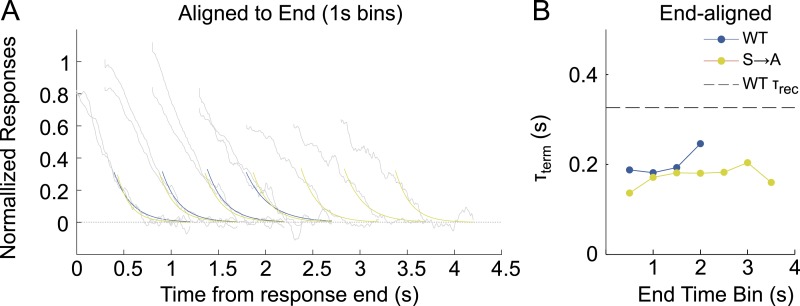
Termination-aligned S → A responses exhibit recovery time constants of ∼200 ms.(A) Responses from WT and S → A lines were binned according to their duration, in 1-s wide bins every 0.5 s (oversampling) and aligned to their termination points (gray lines). An exponential function (A*exp(−t/B)) was fit to the decline, after crossing a defined threshold (0.25) (blue, WT; yellow, S → A). (B) Time constant of termination-aligned decay (τterm) as a function of the bin center. Dashed line shows the recovery time constant of the average WT SPR.